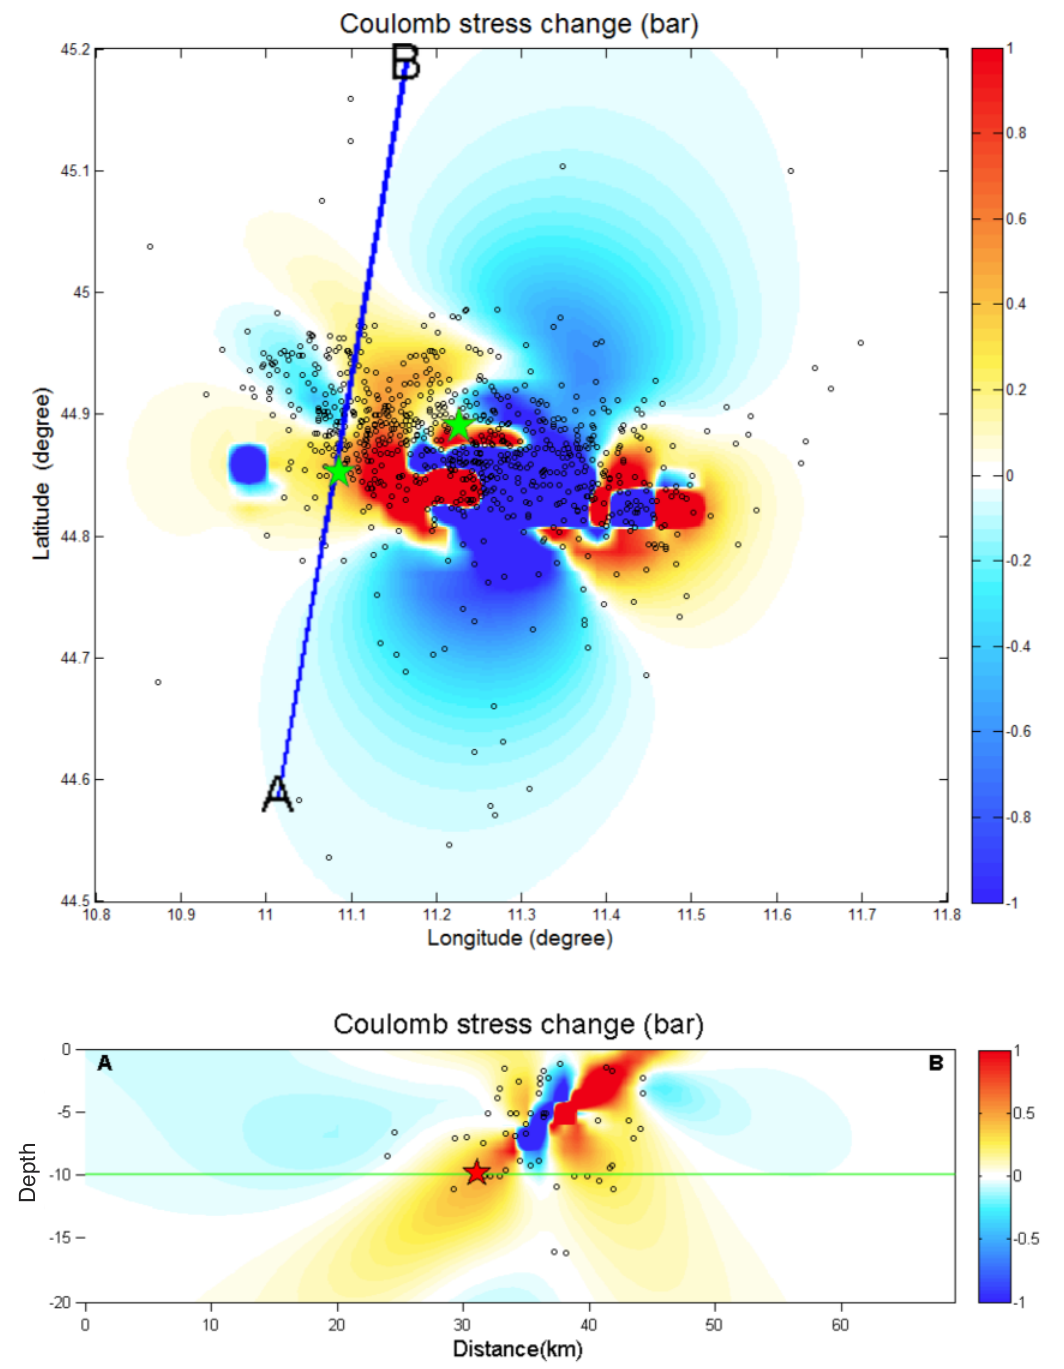
Figure 6. Coulomb stress distribution as in Figure 5, but for low-angle, reverse receiver faults striking N100˚E with friction of 0.4. Open circles, consequent events after May 20, 2012, mainshock. (a) Map and (b) vertical cross-section. Green line, horizontal section of D CFF distribution shown in Figure